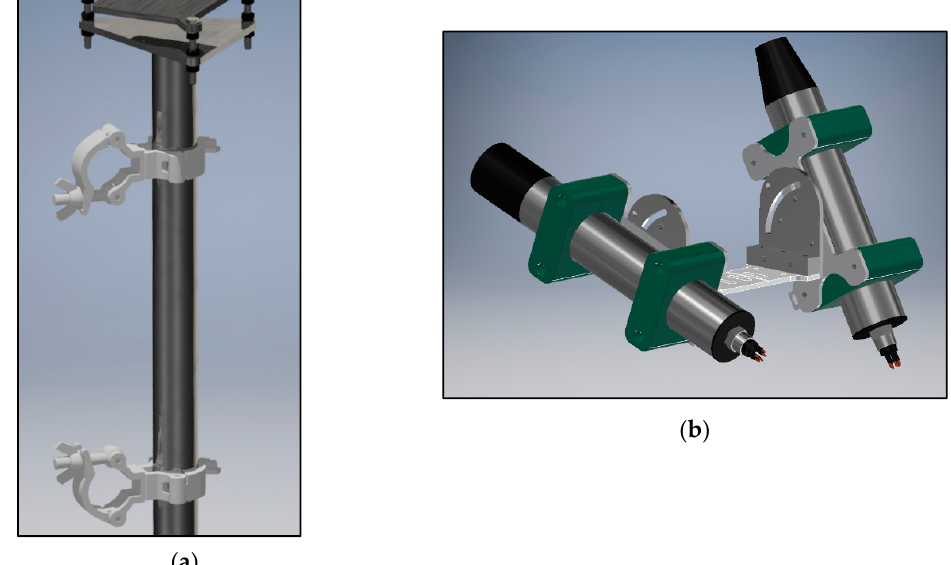
Figure 2. Engineering drawings of mounting structures. ( a ) Support providing a flexible connection between a platform structure, e.g., horizontal railings or a vertical post fixed through the swivel couplings, and pan / tilt unit to be mounted on uppermost horizontal surface; ( b ) sensor mounting bracket for attaching radiometers to top of pan / tilt unit.